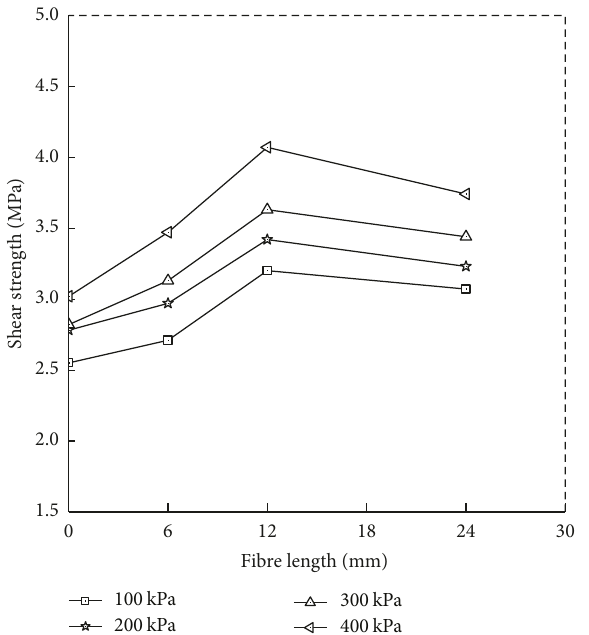
Figure 11: The relationship between fibre length and sample